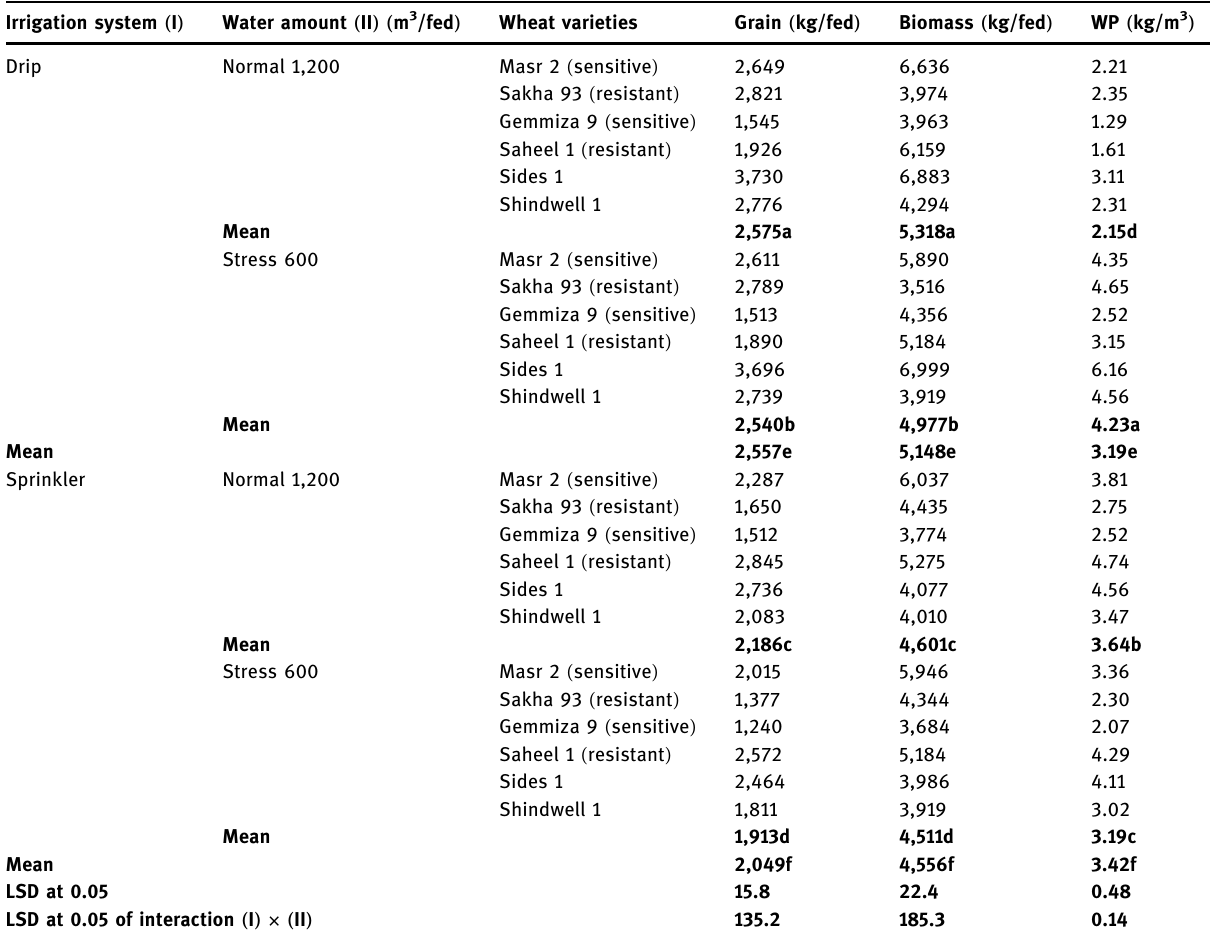
Table 5: E ff ect of irrigation system, water stress, wheat varieties of grain, biomass yield and water productivity Irrigation system ( I ) Water amount ( II ) ( m 3 /fed